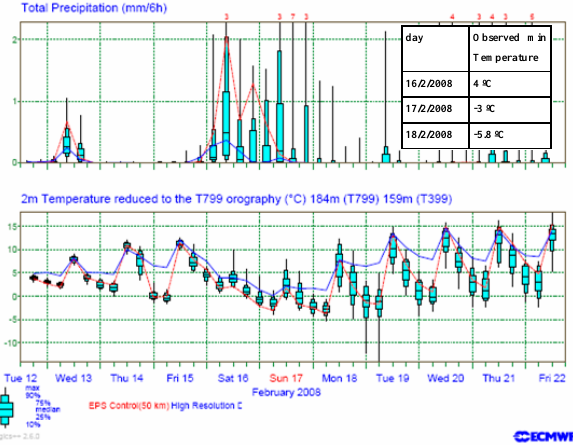
Fig. 4. Athens EPSgram based on 12 February 1200UTC-cycle. The red line represents the control run (50km resolution) of the EPS, the blue line represents the deterministic model run (25km resolution), while the bars represent the percentiles of the ensemble prediction. The superimposed table includes indicative minimum temperatures observed in the GAA each day. It is noted that the EPS location for Athens is actually in the south of GAA.